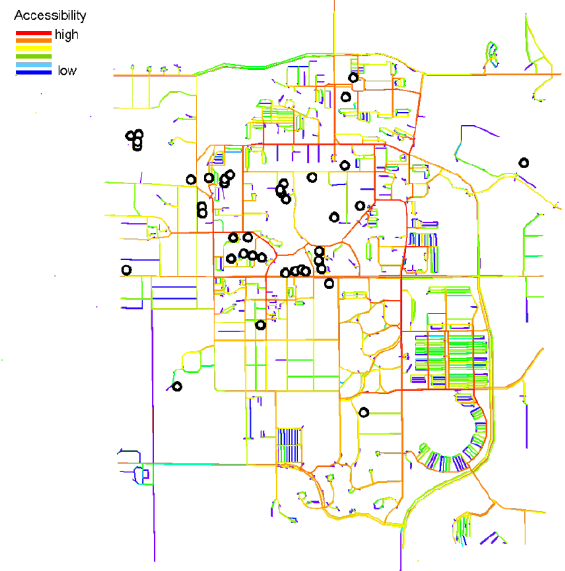
7(b) Zoom-in of the local potential through movement: Iowa